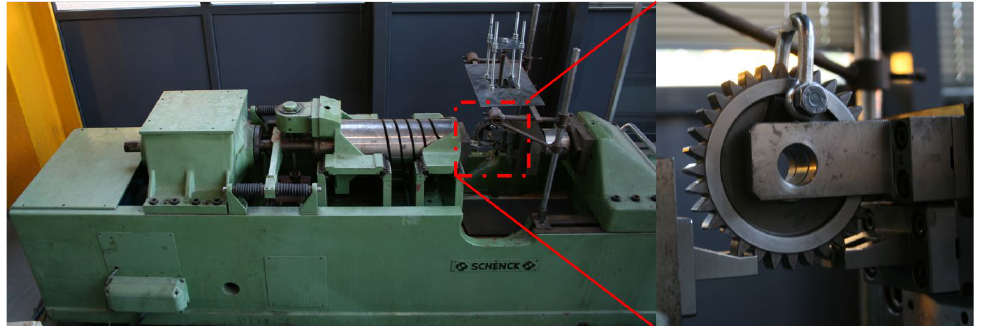
Figure 3. The Schenck mechanical resonance pulsator adopted at POLIMI. To maintain the specimen in position, pulsator tests must be run with a fixed